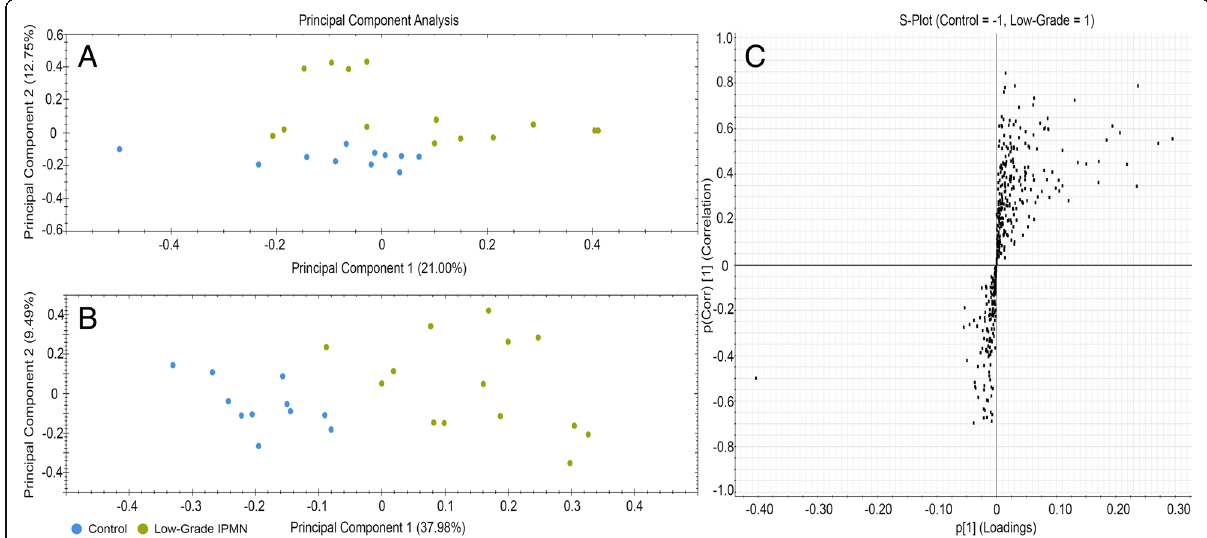
Fig. 1 A representative Principal Component Analysis (PCA) and Orthogonal projections to latent structures-discriminant analysis (OPLS-DA) visualized by S-PlotPCA of Control vs Low-grade dysplasia when all the proteins were considered for PCA ( a ) and when only ANOVA passing proteins ( p value < 0.05) were considered for PCA ( b ). Orthogonal projections to latent structures-discriminant analysis (OPLS-DA) visualized by S- Plot ( c ). 0 to − 1 space contains proteins higher in controls and 0 to + 1 space contains proteins higher in low-grade dysplasia. X-axis is p [1] loadings which tells about the magnitude of variance and Y-axis is p(Corr) [1] which tells about the reliability of the predictive variance. A cutoff of > + 0.7 or < − 0.7 for p(Corr) [1] was used to find significantly different proteins between the